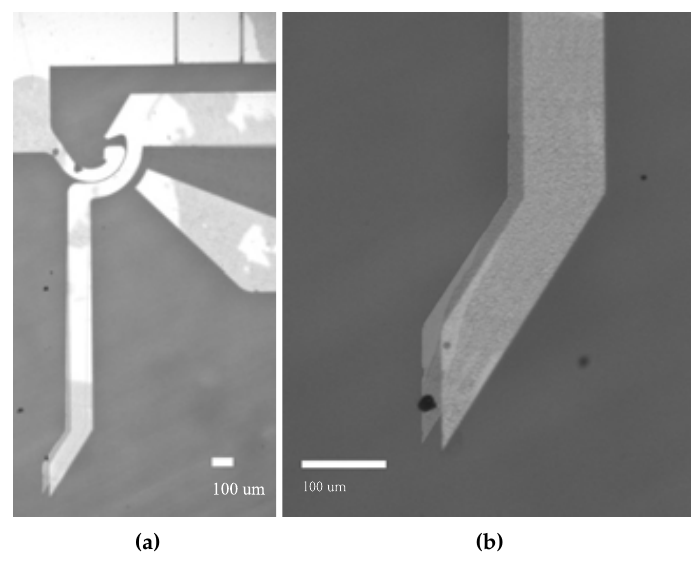
Figure 9. Experimental test corresponding to the applied voltage of 11 V: gripper arm and comb drive ( a ) and jaw detail ( b ).